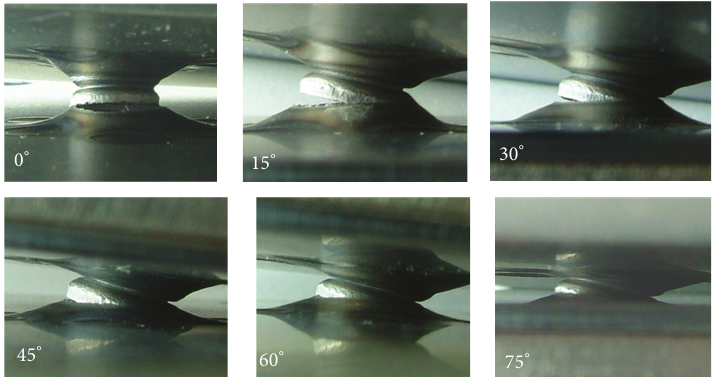
Figure 9: Deformed shape of the specimen made of DP590 spot welds at various loading angles with the tensile speed of 1.2